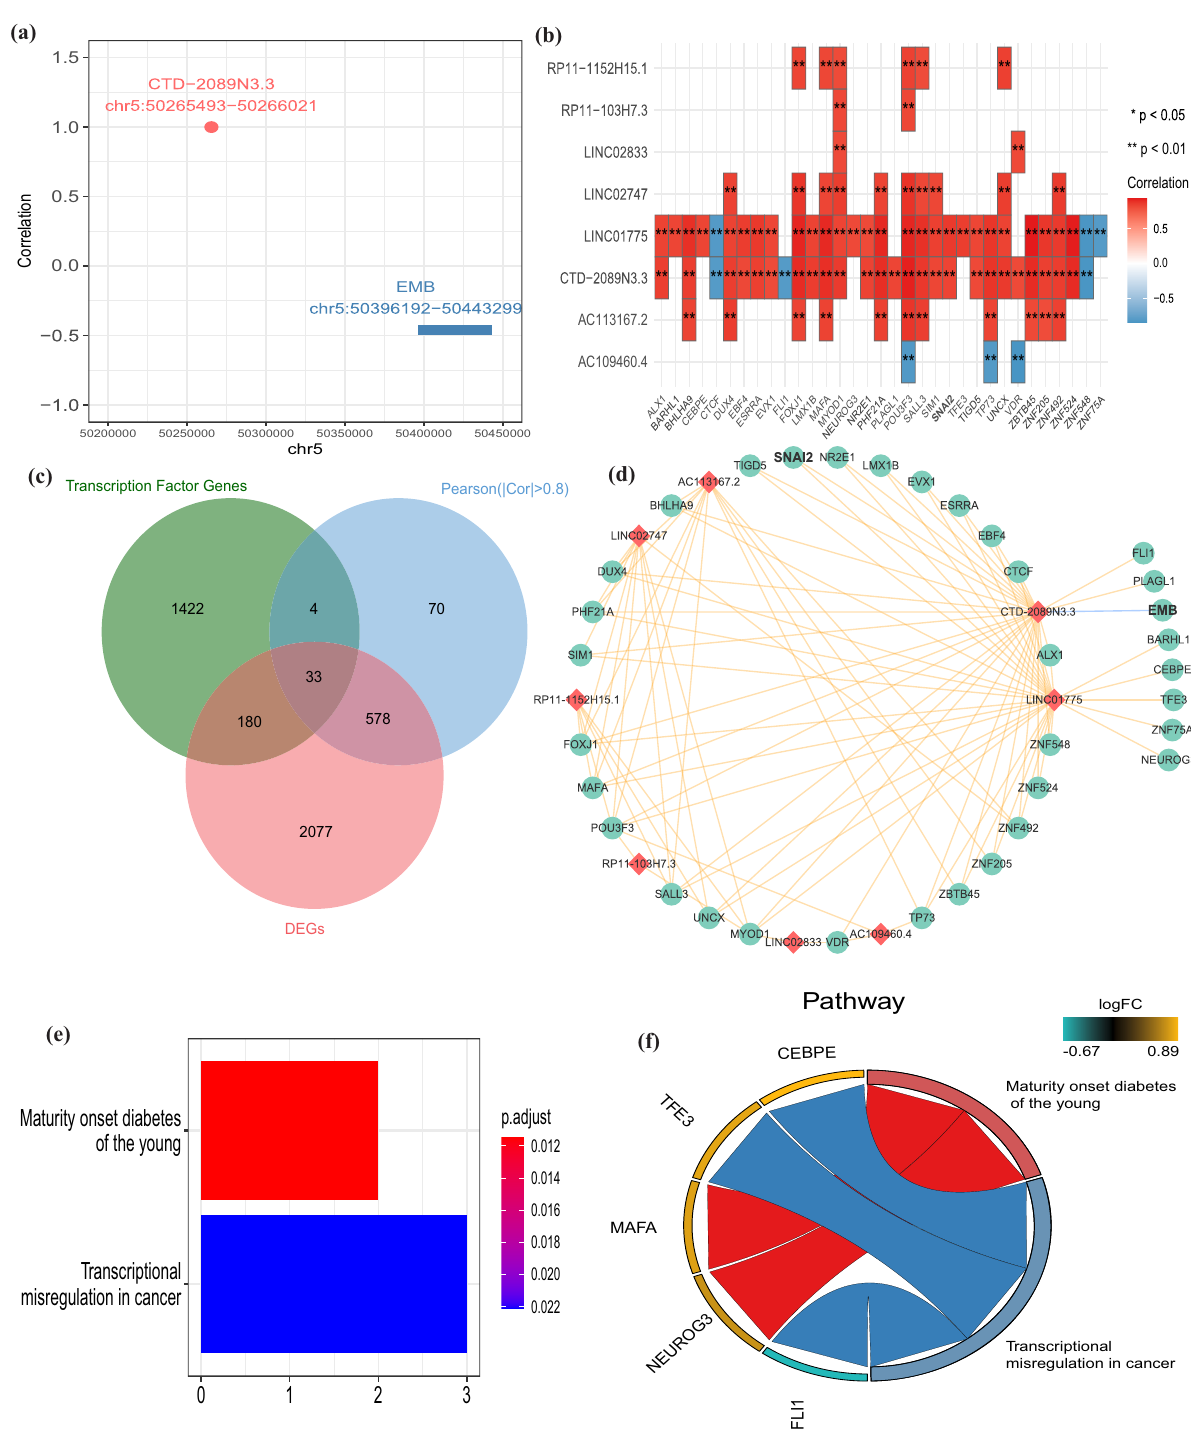
Figure 4: The cis and trans network of the EMT - related lncRNAs. ( a ) Cis - regulation gene of lncRNA CTD - 2089N3.3 in the chromosome. The X - axis represents lncRNA position in chromosome and the Y - axis represents correlation coe ffi cient of lncRNA and the potential “ cis ” gene. The red line represents the genome width of lncRNA and blue point represents the position of potential “ cis ” gene. ( b ) Heatmap of the correlations between eight EMT - related lncRNAs and trans - regulated genes. ( c ) Venn diagram of 33 “ trans ” genes regulated by eight EMT - related lncRNAs. ( d ) The cis and trans network of the eight EMT - related lncRNAs ( red ) in CAD and their target mRNAs ( green ) . ( e and f ) KEGG enrichment analysis of 34 cis and trans genes regulated by EMT - related